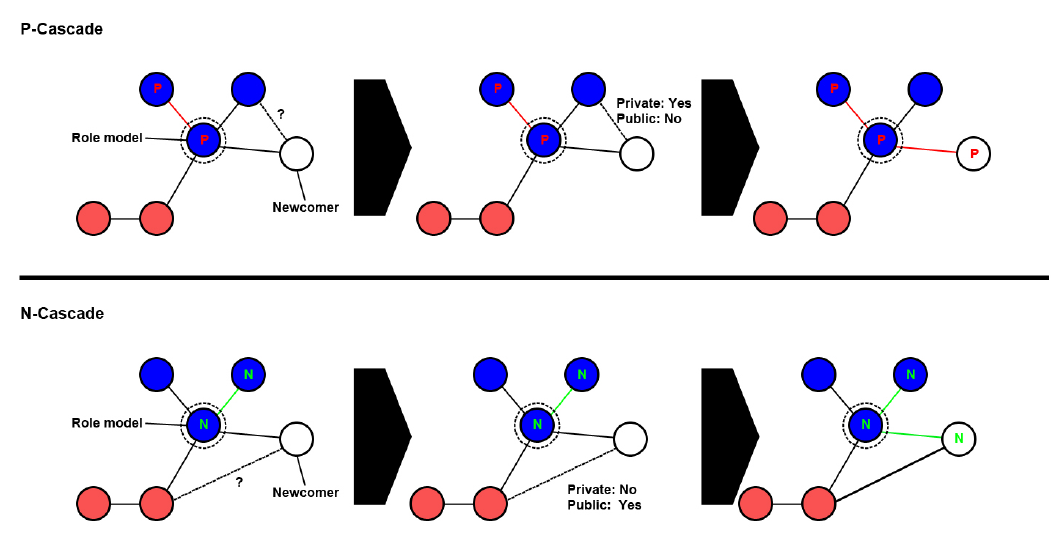
Figure 4. An illustration of the two types of cascades that are monitored and and how they can potentially propagate as newcomers join the network. A P cascade is considered to have occurred when a node does not form a connection with another cooperator based on misleading public information. A N cascade is considered to have occurred when a node incorrectly forms a connection with a defector based on misleading public information. Diagram is based on illustration presented in [17] used to describe the progression of cascades in cooperative